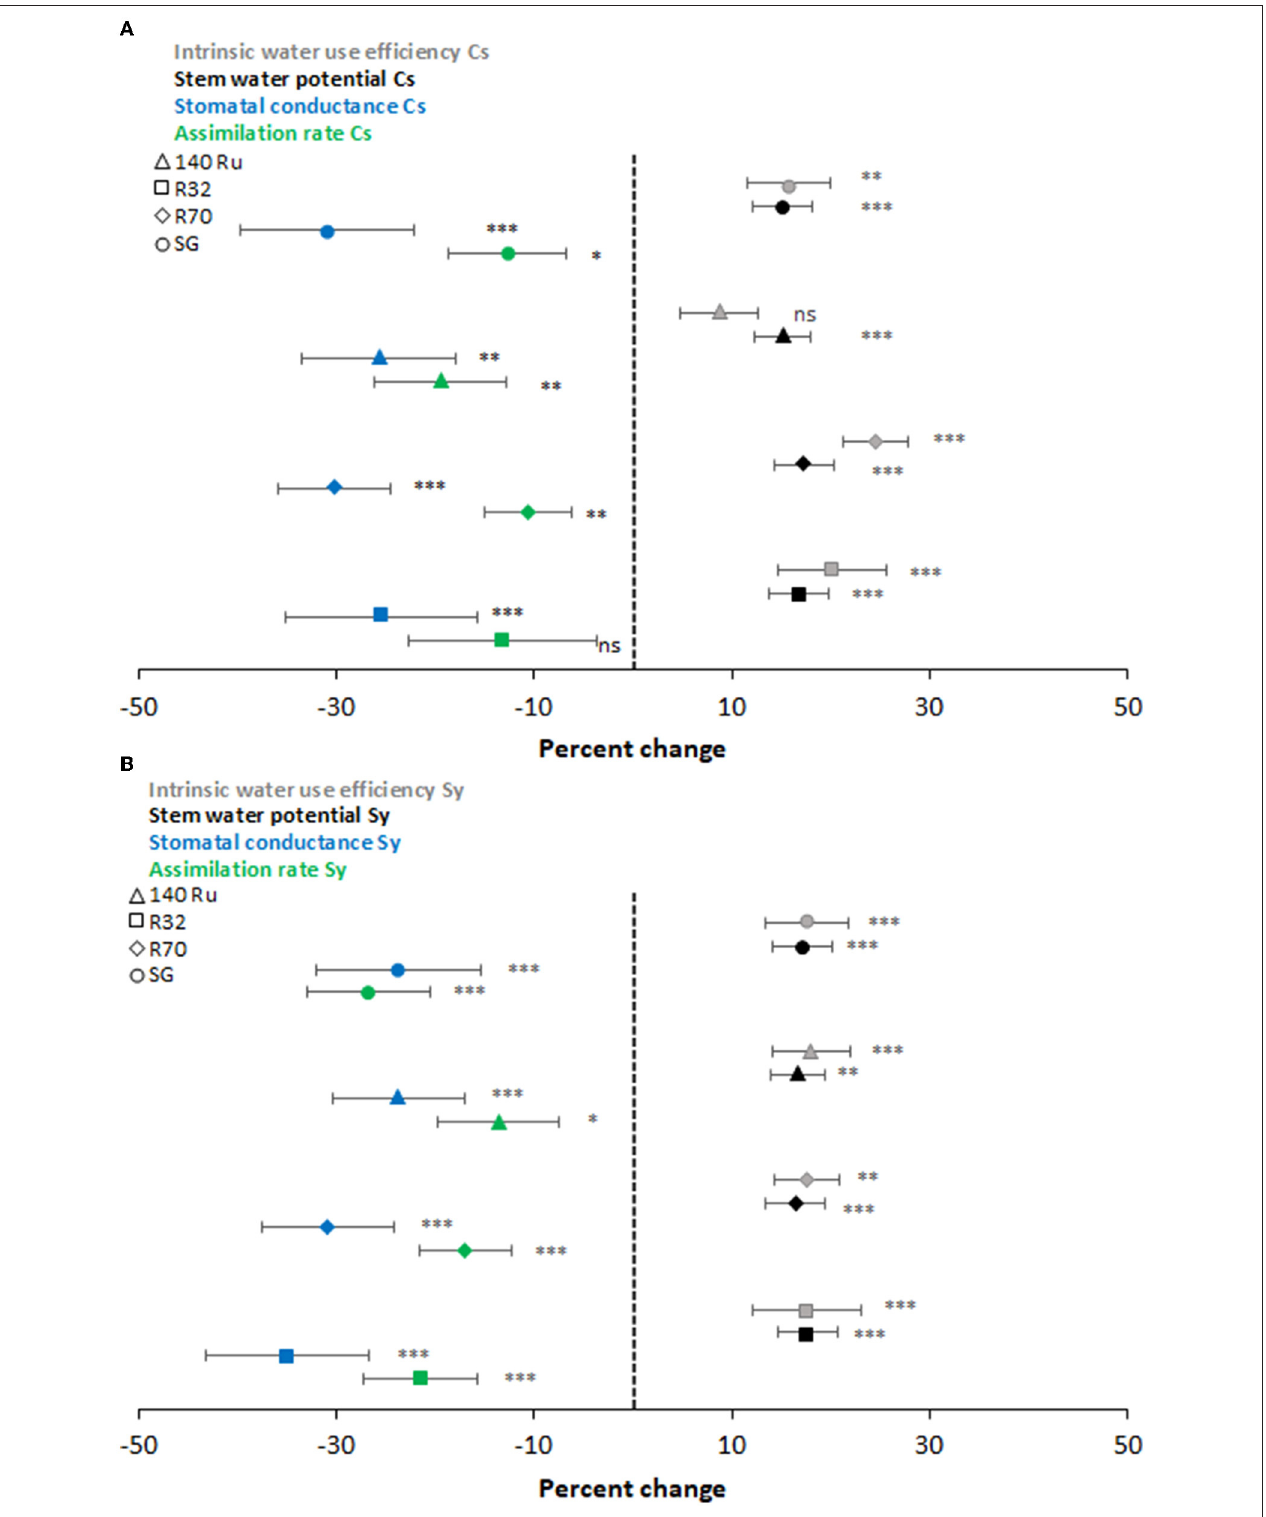
FIGURE 1 | Percent change of intrinsic water-use efficiency (gray), stem water potential (black), stomatal conductance (blue), and assimilation rate (green) under two different moderators: hydric contrasting cultivars (CS— A ; and Sy— B ) and rootstocks (140Ru - triangle, R32-square, R70 -diamond, and SG-circle). Asterisks near the symbols specify the significance, and the error bars show the 95% confidence interval (CI).